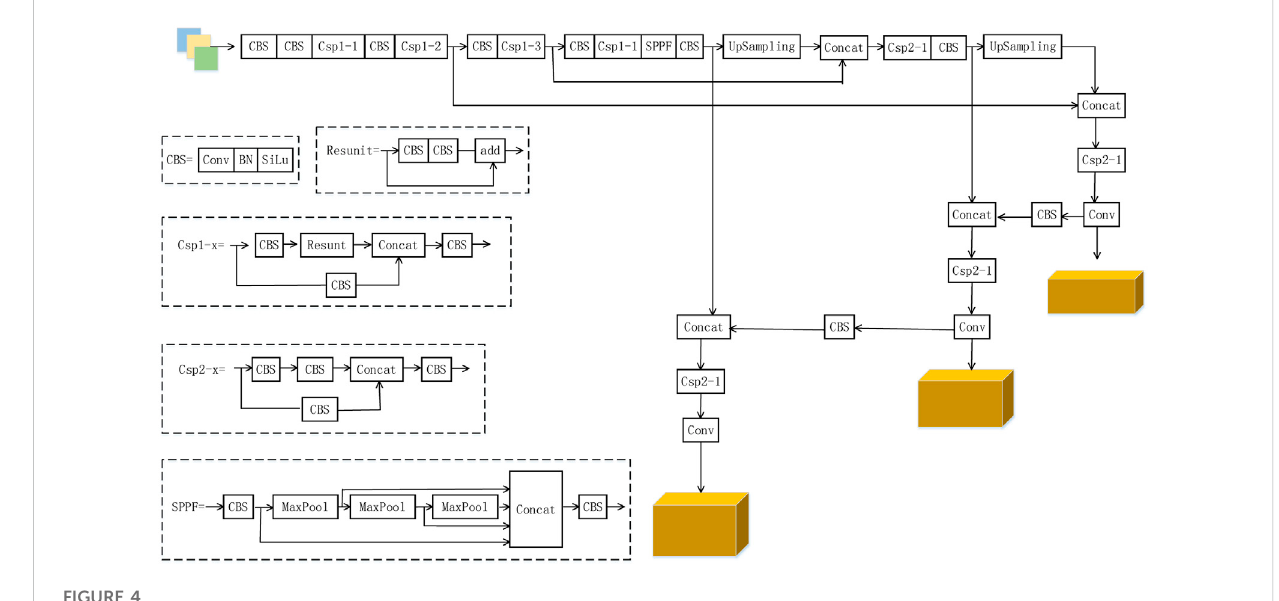
FIGURE 4 YoloV5 network structure.